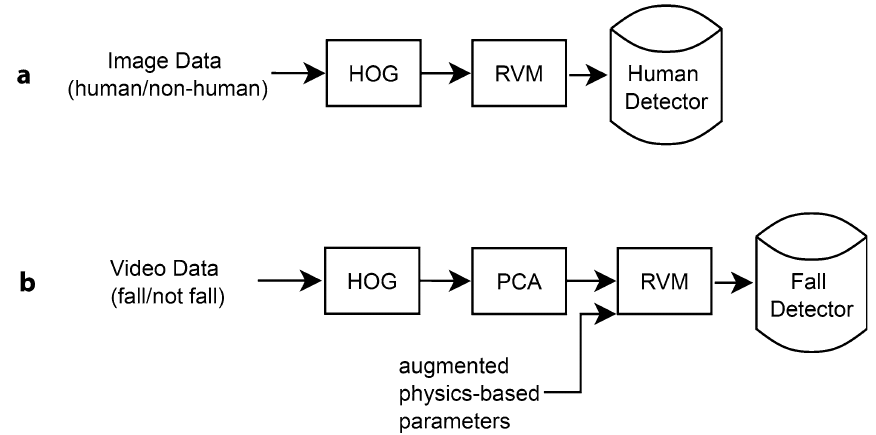
Figure 8. The main pipeline for training ( a ) our human detector and ( b ) our fall